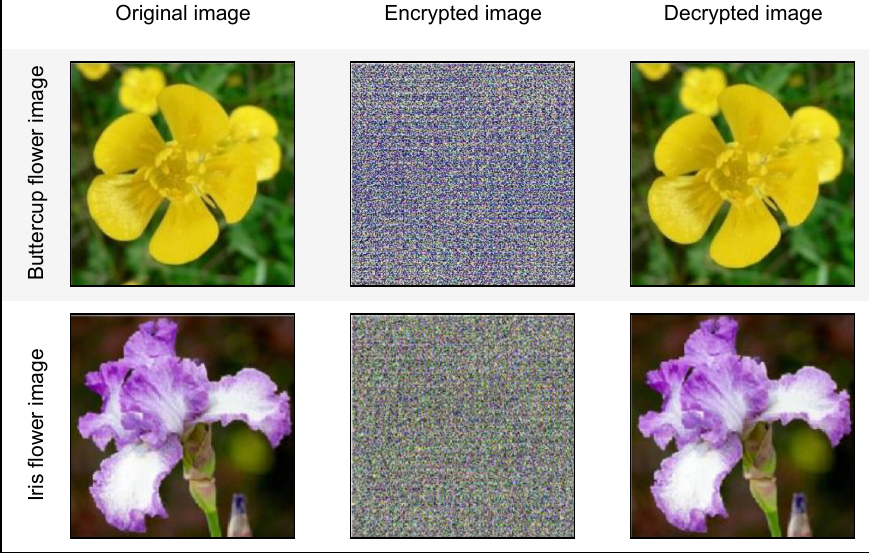
Figure 12. Original, encrypted, and decrypted Buttercup and Iris